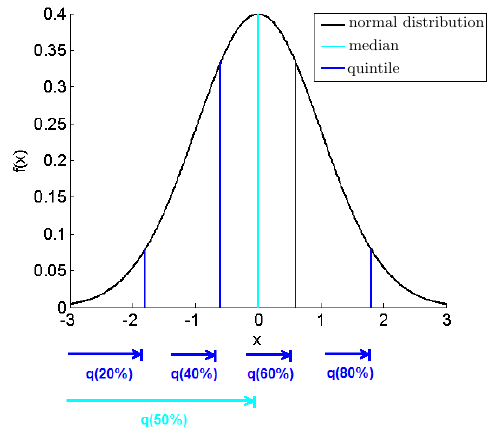
Figure 6. Quintils of a normal distribution.